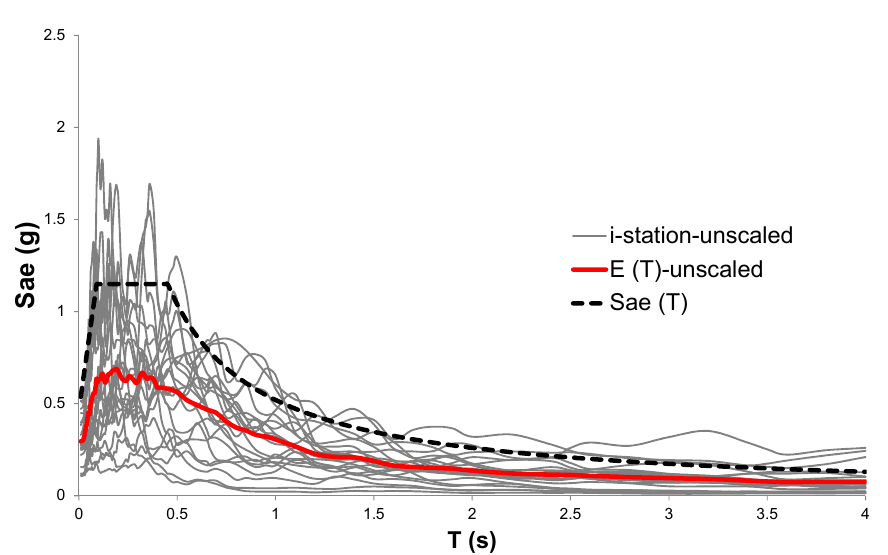
Figure 5. The spectrum of unscaled acceleration records. The SRSS spectrums belonging to the 11 acceleration record pairs and their average spectrum, E(T), are given in Figure 6. In addition, the 1.3 times target spectrum S ae (T) for the soil class ZD is given in the same figure. The acceleration spectrum and average spectrum of 11 scaled acceleration record pairs are plotted in Figure 7. The properties of the selected earthquake records and scale factors are provided in Table 6. The scale fac- tors ranging between 1.48 and 1.95 are reasonably well.